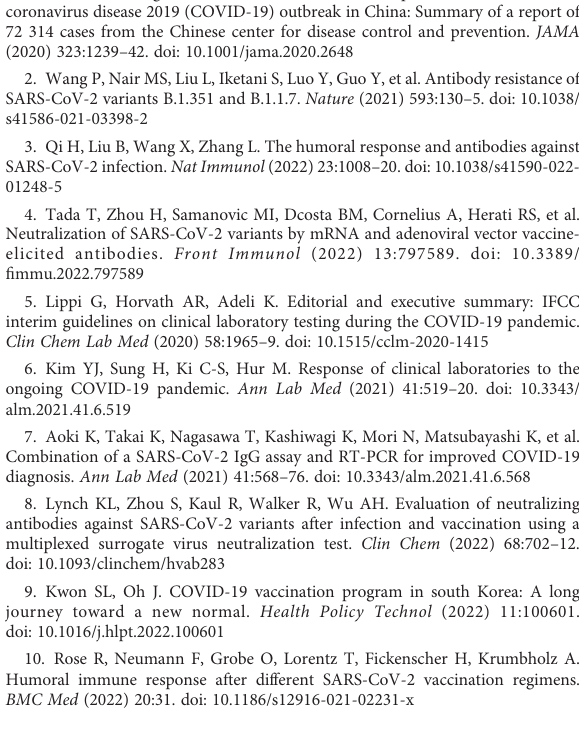
SUPPLEMENTARY FIGURE 1 Seroconversion of SARS-CoV-2 antibodies by multiplex-bead assay (A) and Roche, GenScript assay (B) in patients with COVID-19 severe (solid line) and mild infection (dotted line). * P<0.05, ** P<0.01 SUPPLEMENTARY FIGURE 2 Intraindividual changes in SARS-CoV-2 antibody levels by multiplex-bead assay (A) and Roche or GenScript assay (B) after AZ and BNT vaccination. Fold change indicates the difference between antibody levels 1 month after 1st-dose (1MoA1D), 1 month after 2nd-dose (1MoA2D) and 3 months after 2nd-dose vaccination